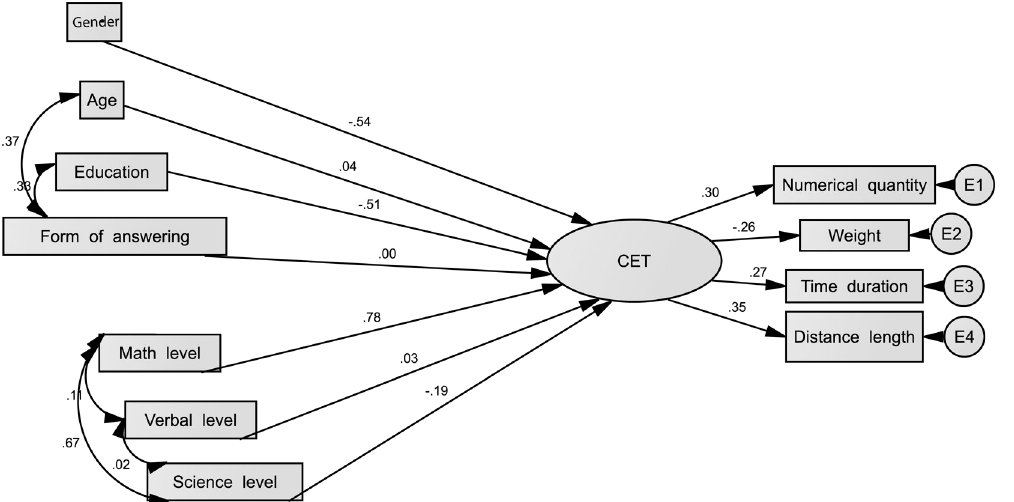
Figure 1. To test the multivariate relations between estimation and cognitive factors, we created a theoretical model. Note. We used SEM to test our theoretical model. The result indicated that gender, education, and math level predicted estimations. Age, form of answering, and writing level and science level did not. All the values are standardized.